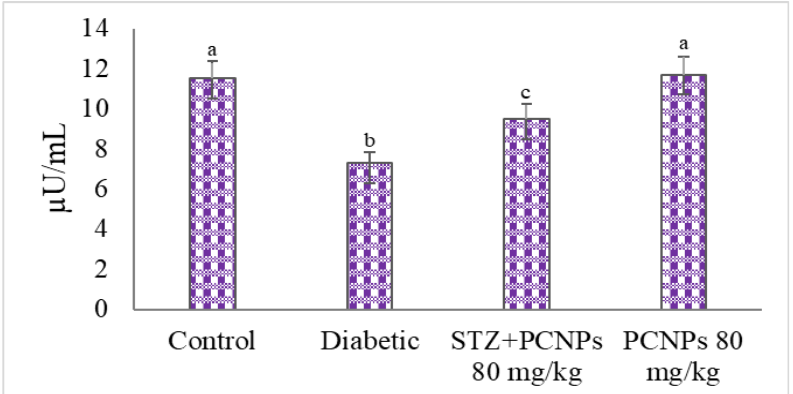
Figure 2. Activities of PCNPs on insulin of experimental and control group. Values are means ± SD for six rats at p < 0.05 (DMRT). a PCNPs alone treated group compared with control group. b Diabetic group compared with control group. c Treatment group compared with diabetic